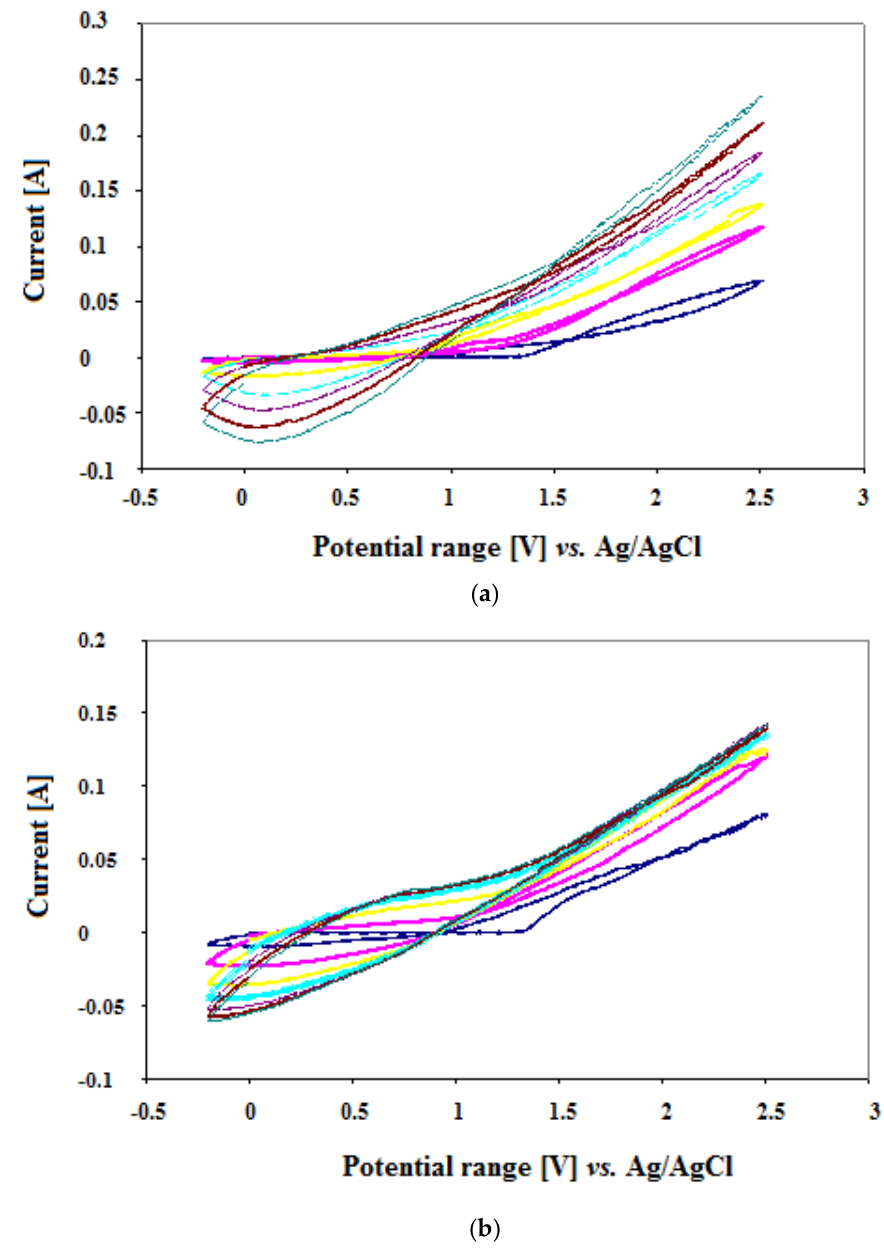
Figure 1. Voltamperograms obtained during the electropolymerization process of thiophene, with ( a ) and without ( b ) imprinted drug molecule (CEF). ( a ) demonstrates cyclic scans of electropolymerization of thiophene in the presence of CEF and ( b ) without CEF. Colors mean seven-cycle scans during polymerization.